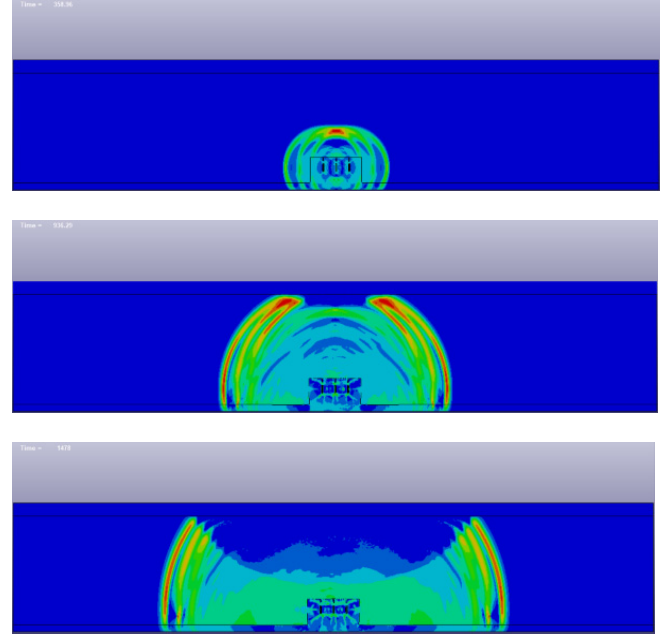
Figure 6. Diagram of shock wave pressure transmission.